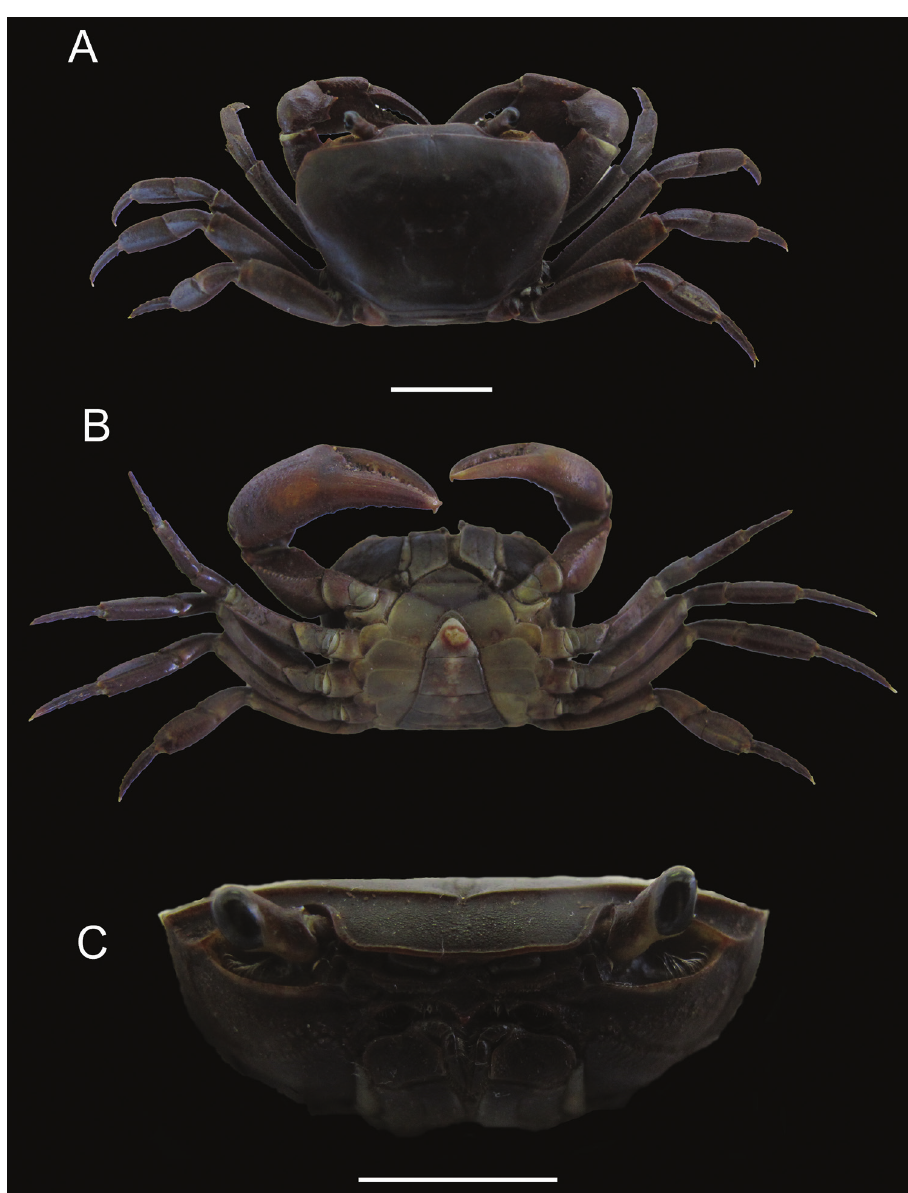
Figure 7. Potamonautes danielsi sp. n. male holotype CWW 25.8 mm (SAMC A83487) A dorsal view, B ventral view, and C cephalothorax, frontal aspect. Scale bar: 10 mm. Photos: Nasreen Peer.